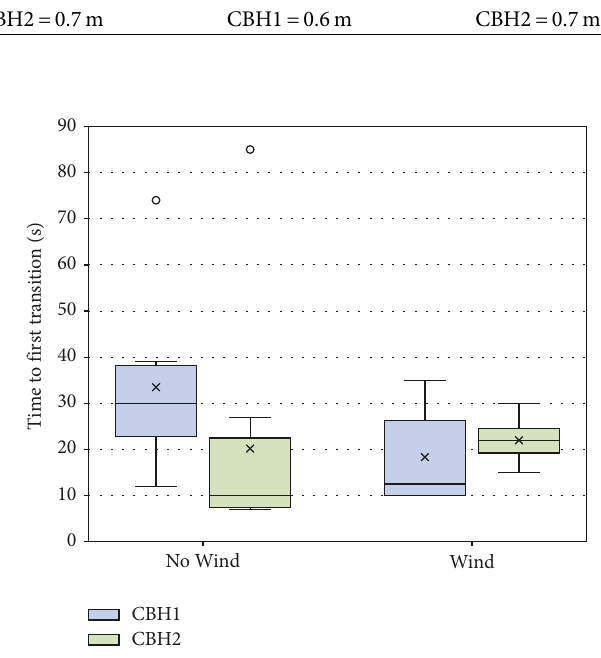
Figure 3: Time to first sustained surface-crown transition for nonwind-driven and wind-driven fires at the two examined crown base heights, where CBH1 � 60cm and CBH2 � 70cm; the symbols outside of the box plots for the nonwind cases are